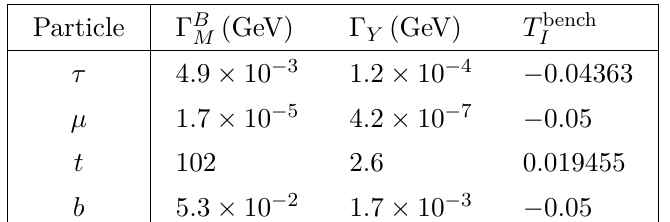
Table 2. Numerical values for Γ B eq. (A.13), with T R = T I = 0 , and the benchmark value for T bench